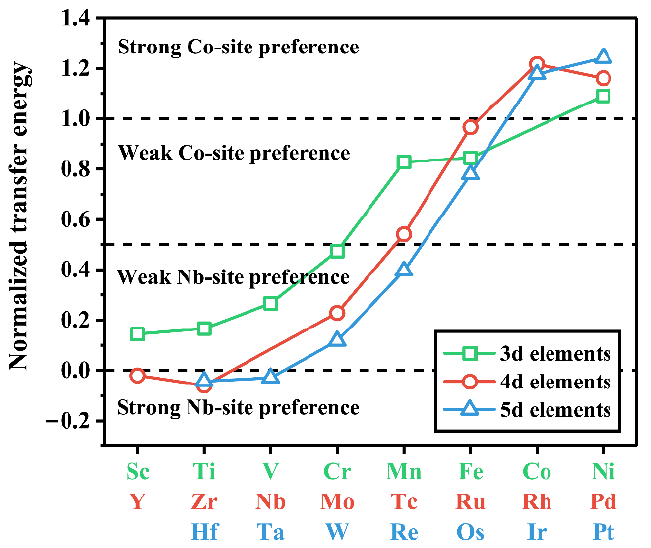
Figure 2. Normalized transfer energy of X-substituted L1 2 Co 3 Nb compounds. Table 1. Calculated formation enthalpies ( ∆ H ), lattice constants (a), transfer energy ( E Co → Nb